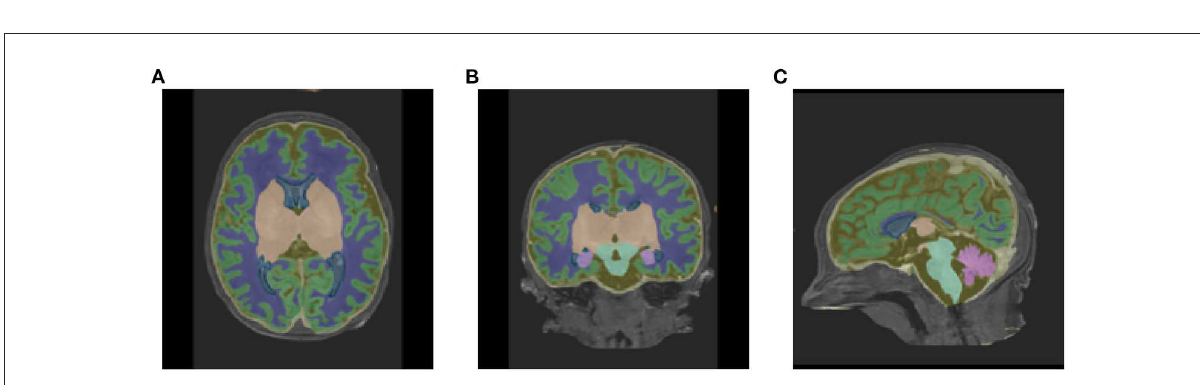
FIGURE7 Segmentation outputs in (A) axial, (B) coronal, and (C) sagittal views produced by the baseline pipeline, visualized on the original T1-weighted scan of a subject with a scan age close to the medium of the distribution (38.86 weeks